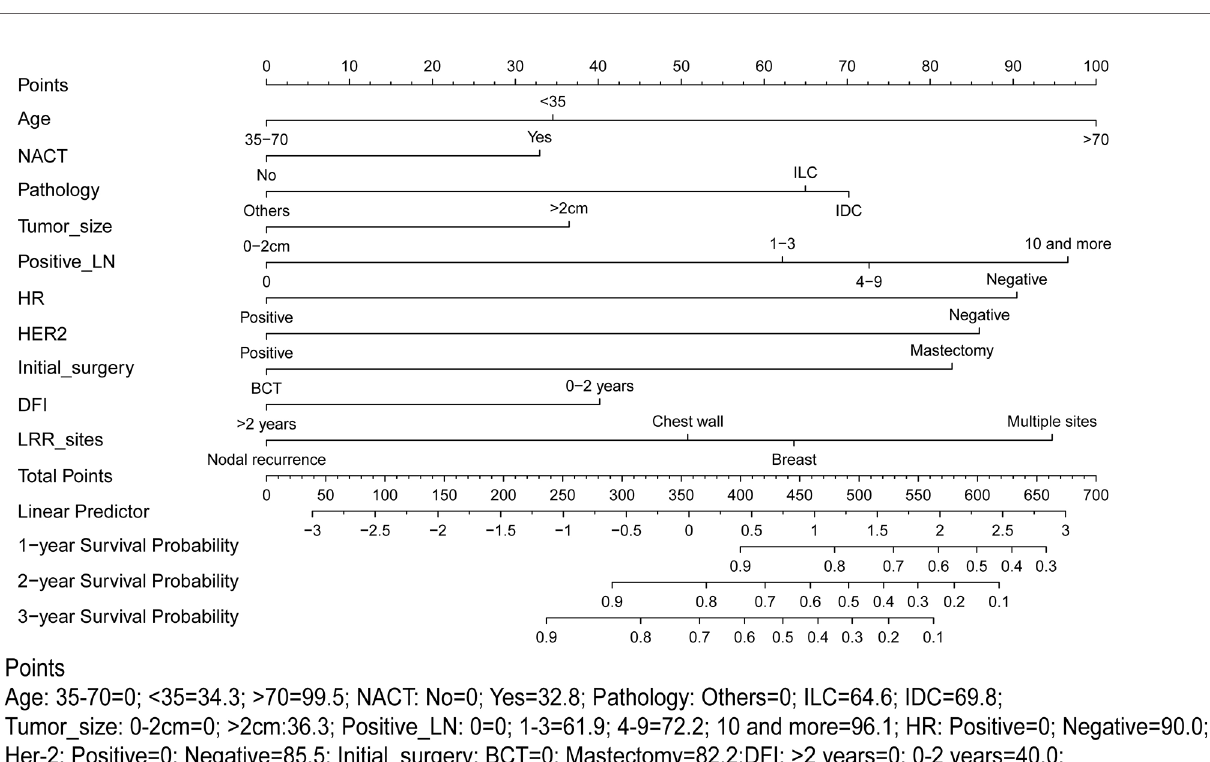
FIGURE 1 | Proposed nomogram using the training cohort to predict the probability of overall survival (OS) after locoregional recurrence (LRR). NACT, Neoadjuvant chemotherapy treatment; LN, Lymph node; HR, Hormonal receptor; HER-2, human epidermal growth factor receptor-2; LRR, Locoregional recurrence; DFI, Time interval from initial surgery to the